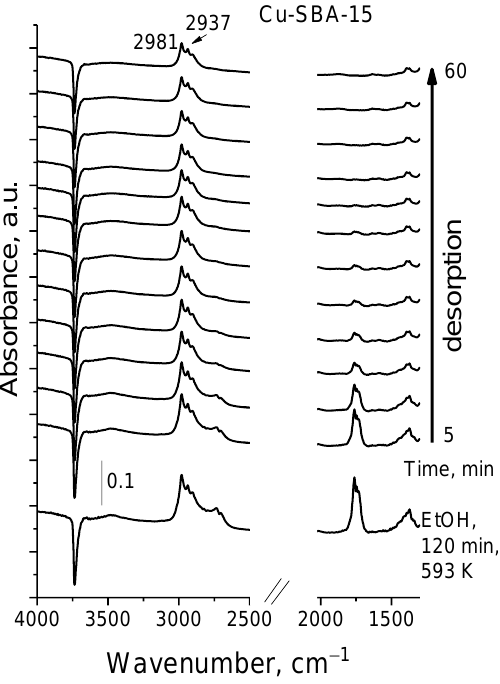
Figure 7. FTIR spectra (4000–1300 cm − 1 range) recorded in argon flow at 593 K for 60 min after 120 min of ethanol dehydrogenation reaction at 593 K for Cu-SBA-15.